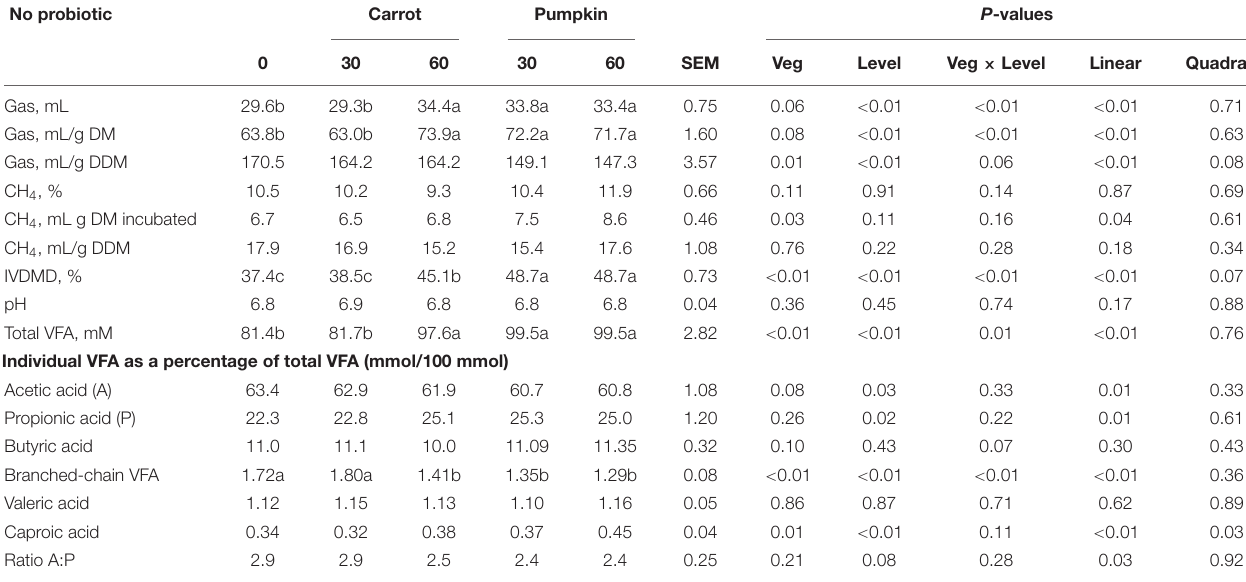
TABLE 5 | In vitro fermentation, gas production, and CH4 parameters of sorghum ensiled with carrot or pumpkin at 0, 30, or 60% DM without (no) probiotics. No probiotic Carrot Pumpkin P -values